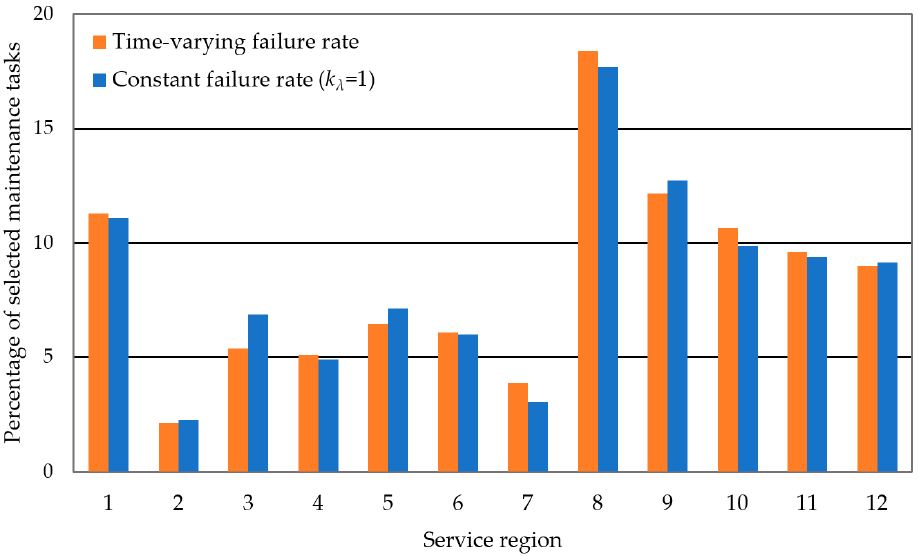
Figure 8. The percentage of the number of selected preventive maintenance tasks by service region.